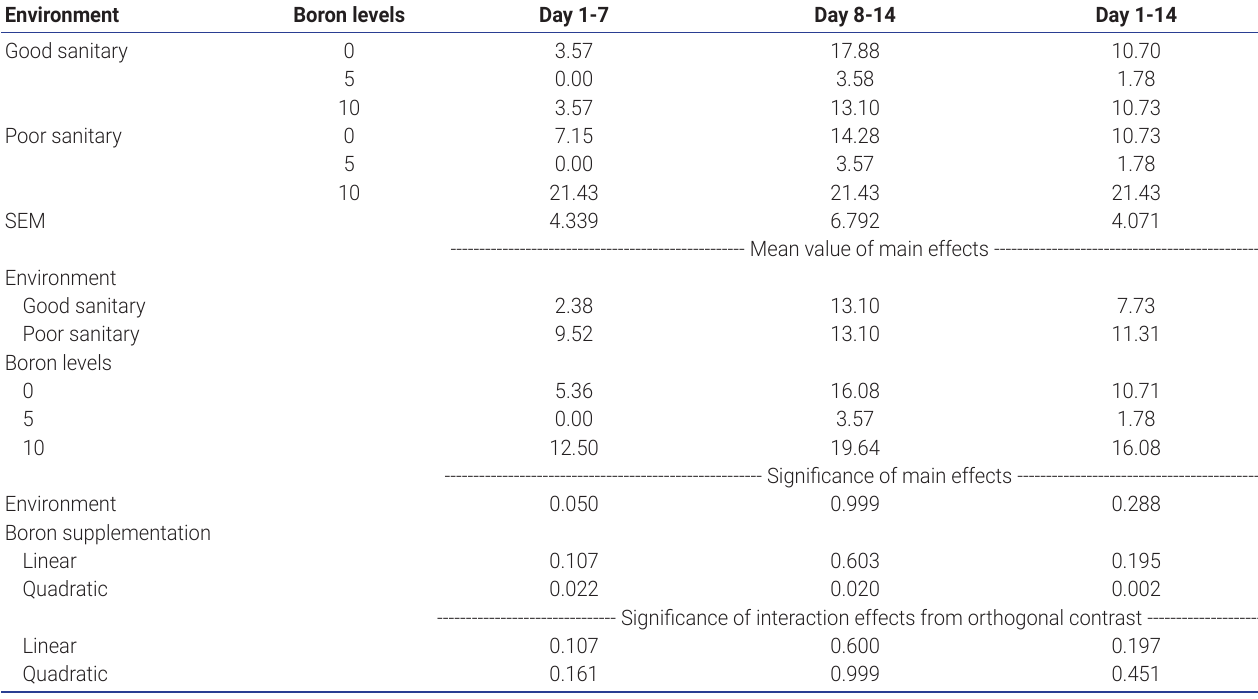
Each simple effect mean represents 6 replicate pens. SEM, standered error of